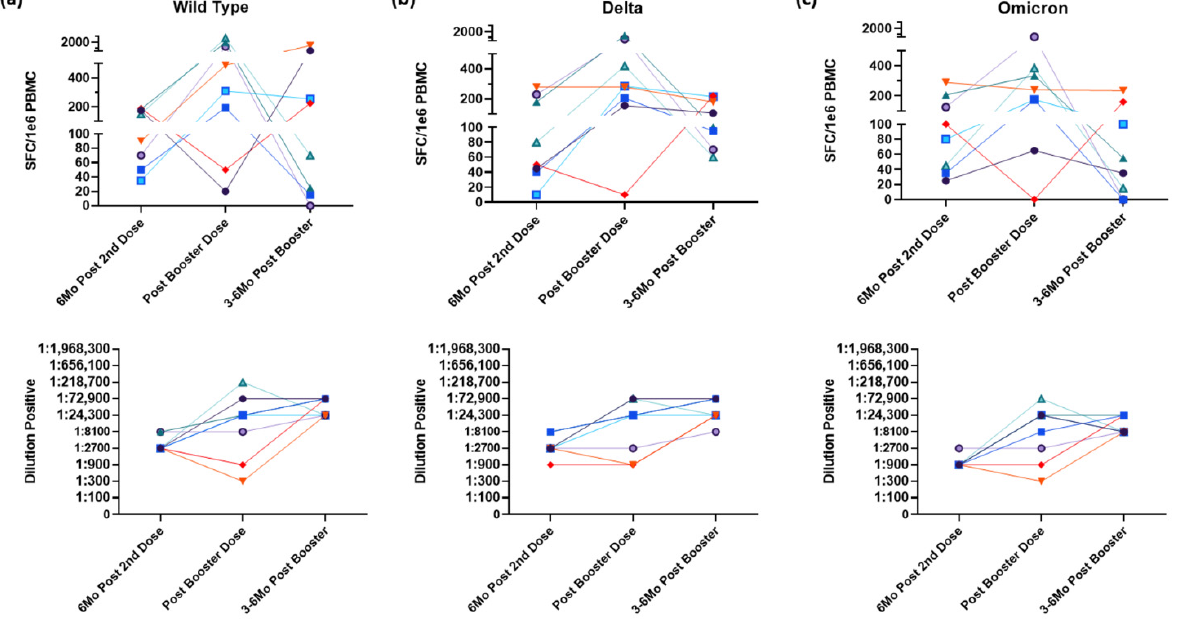
Figure 5. Booster dose raises T-cell and antibody response to both Delta and Omicron variants comparable to unmutated spike protein in individual participants. Spike-specific CD4 + T-cell (top) and antibody (below) response to the wild type ( a ), Delta ( b ), and Omicron ( c ) variants 6 months following second dose, 2 weeks after booster and 6 months after booster. Colored lines represent individual participants across all graphs. Abbreviations: SFC, spot forming